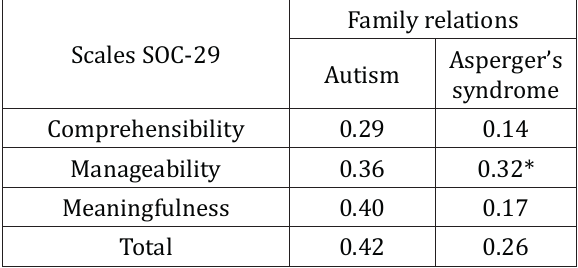
the Burned-Out Scale Table 5. Correlation coefficients calculated between the assessment of family relations and the sense of coherence measured with the SOC-29 questionnaire in the group of mothers of children with autism and Asperger's